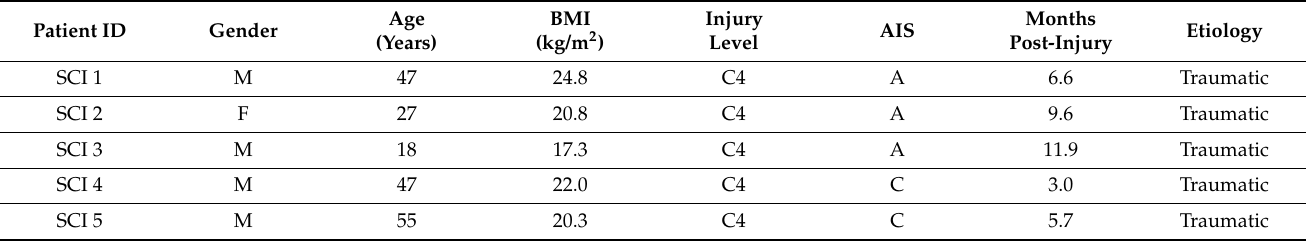
Table 1. Clinical characteristics of the SCI